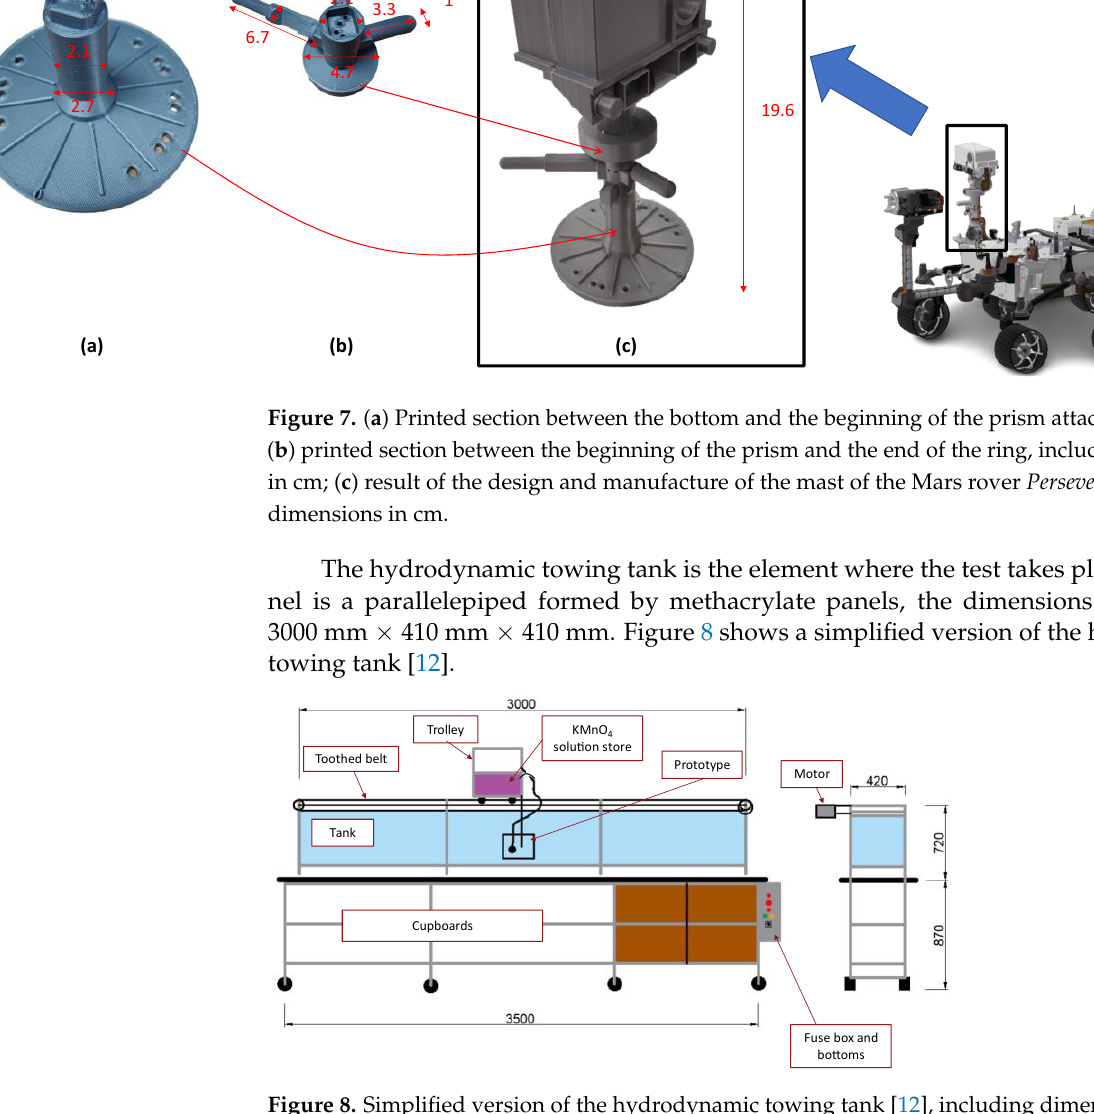
Figure 8. Simplified version of the hydrodynamic towing tank [12], including dimensions in mm.